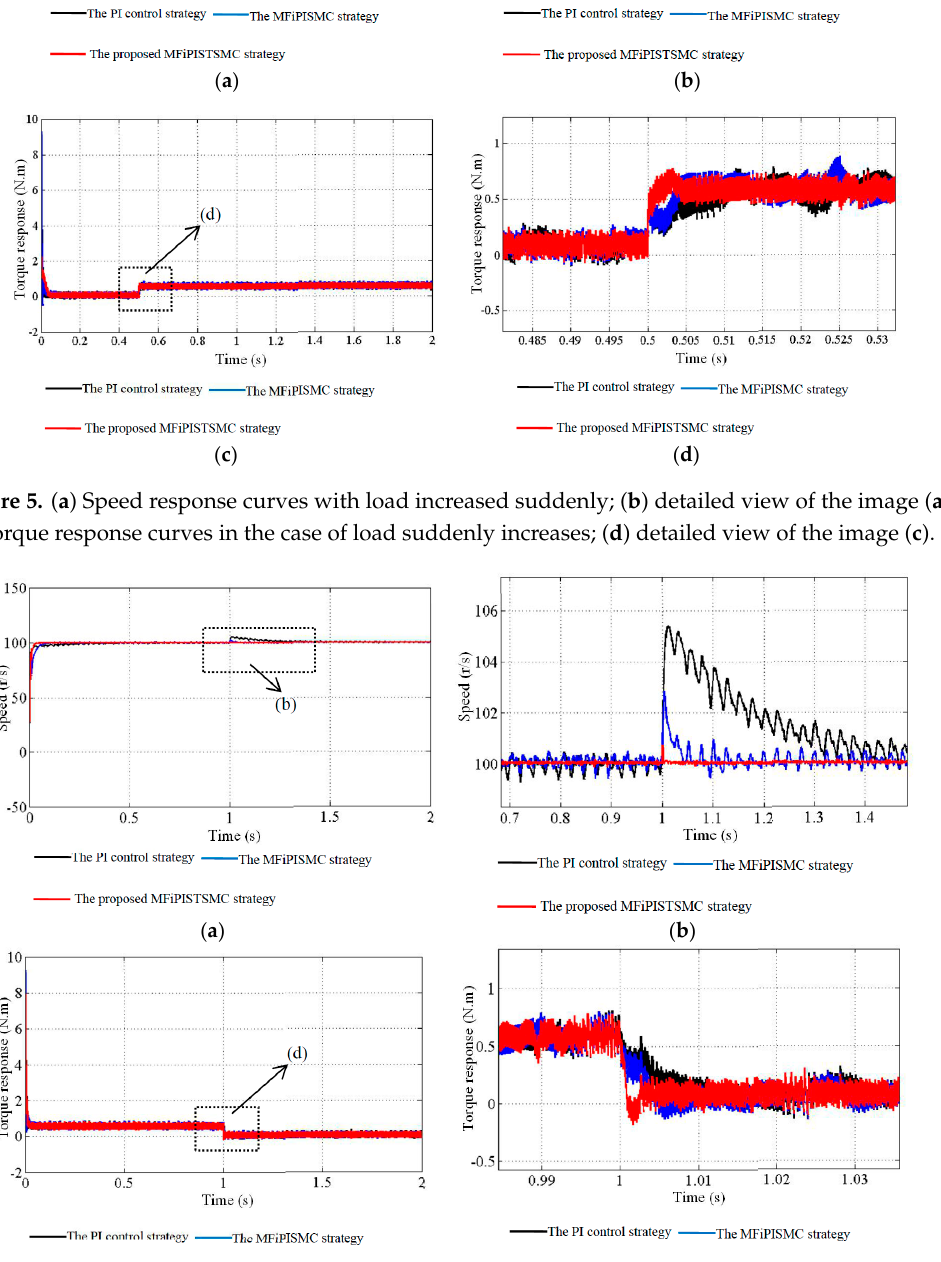
Figure 6. ( a ) Speed response curves with load decreased suddenly; ( b ) detailed view of the image ( a );